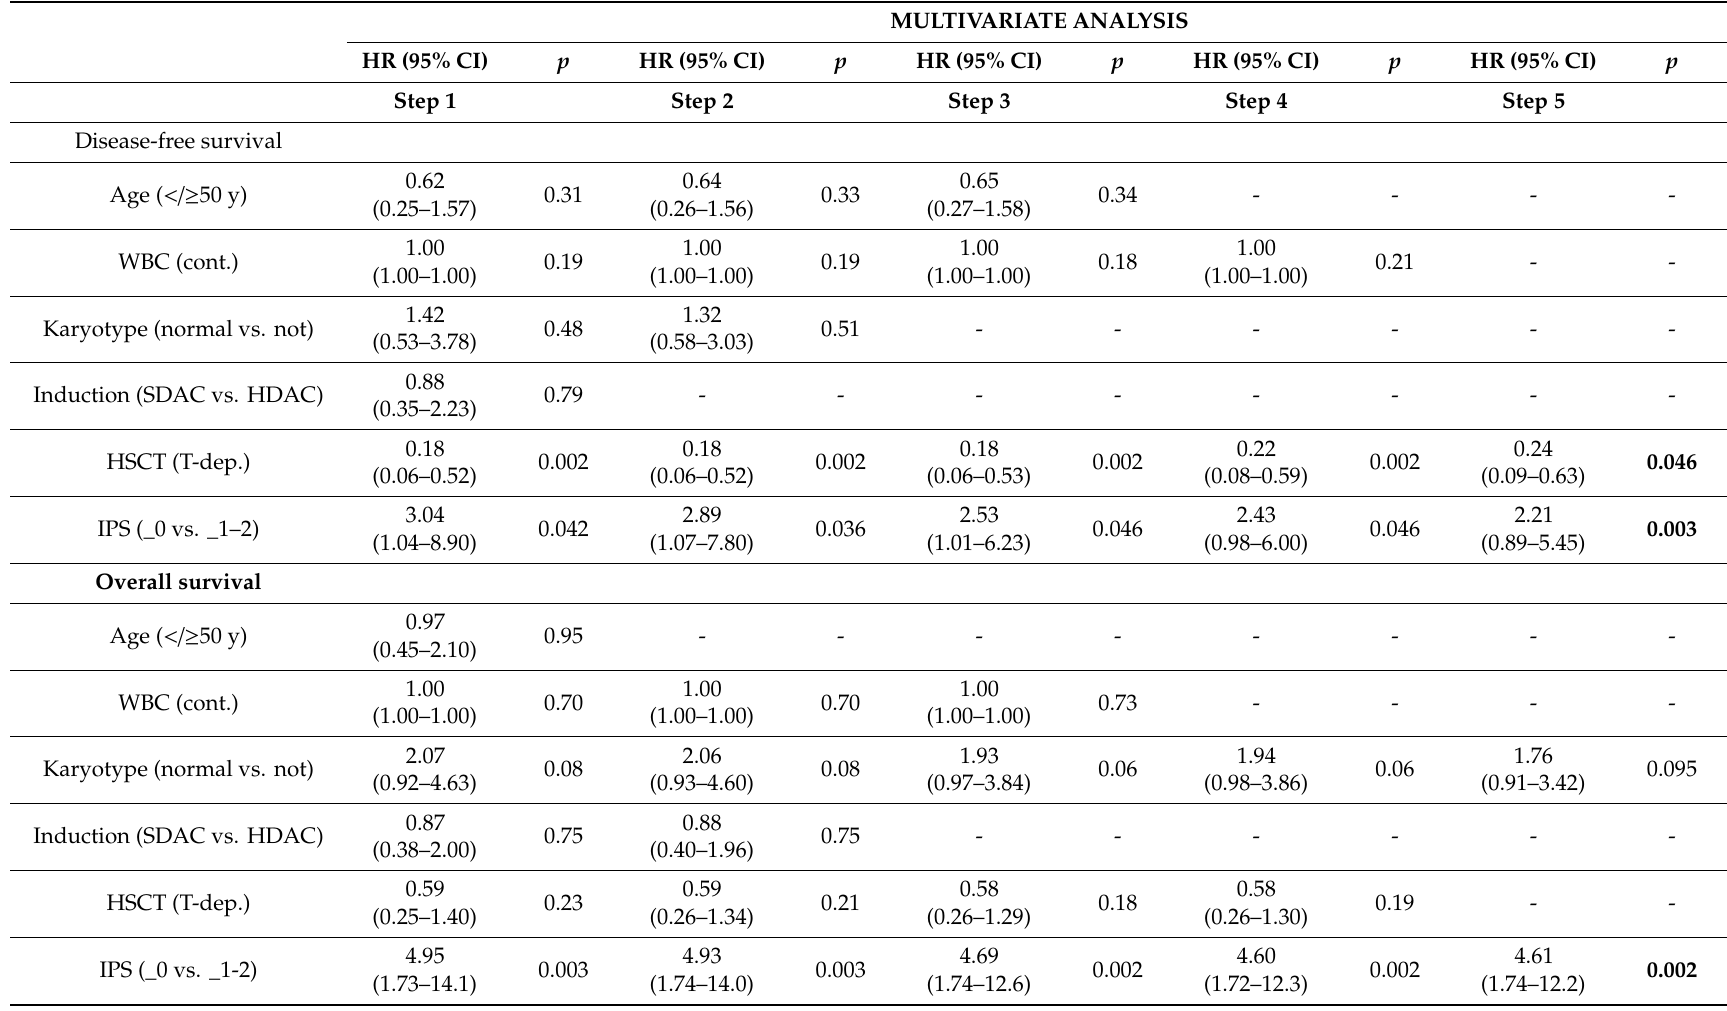
Table 3. Multivariate analyses (Cox regression) for major outcomes in triple-negative